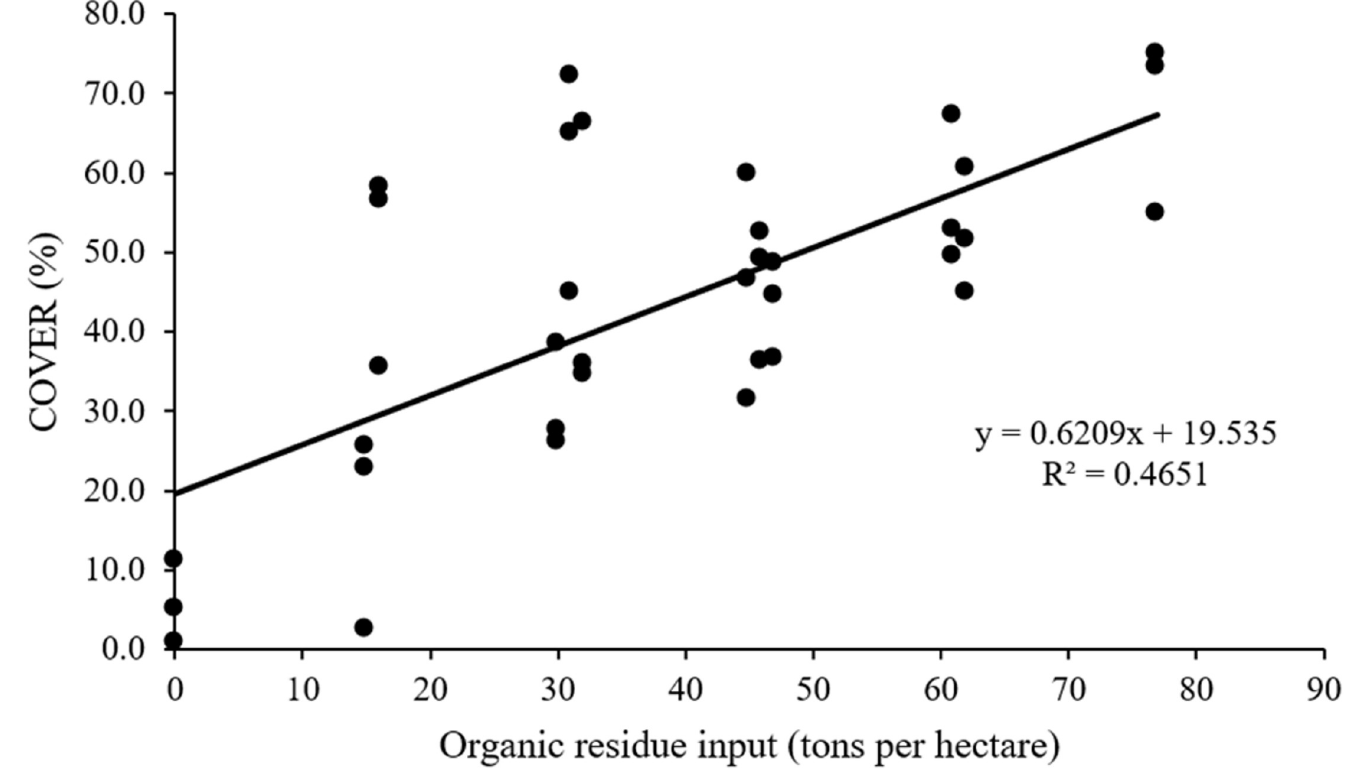
Fig 4. Correlation between ground vegetation cover (COVER) and residue